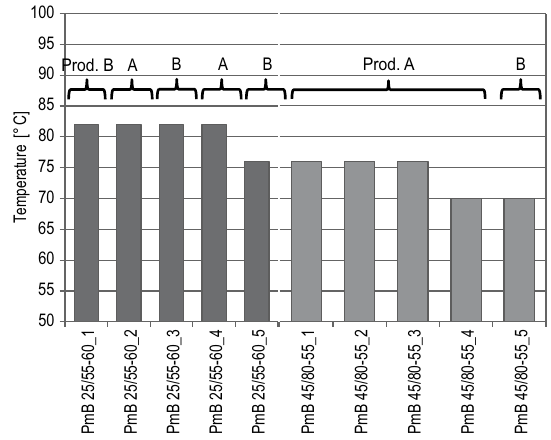
Fig. 10. Upper limit of the performance grade temperature for polymer modified